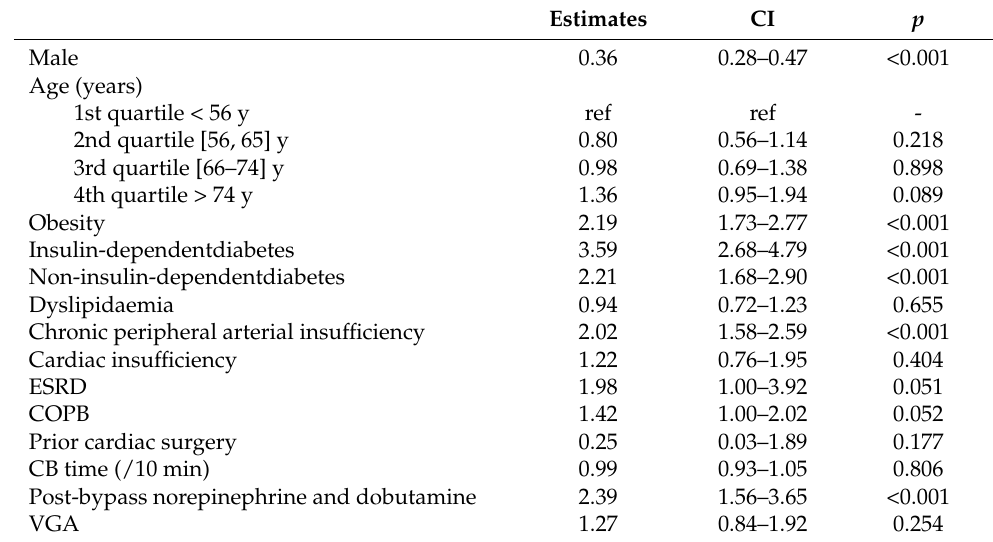
Table 6. Multivariate analysis of risk factors for SSI in a sensitivity analysis restricted to